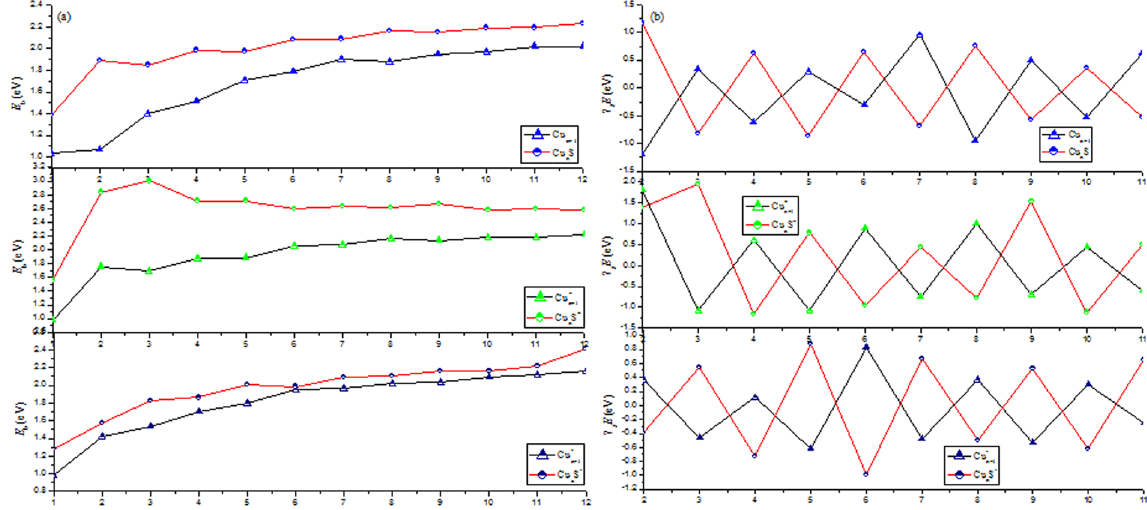
Figure 2. Calculated average binding energies and second-order energy differences of neutral and charged Cu n + 1 and Cu n S (n = 1–12)